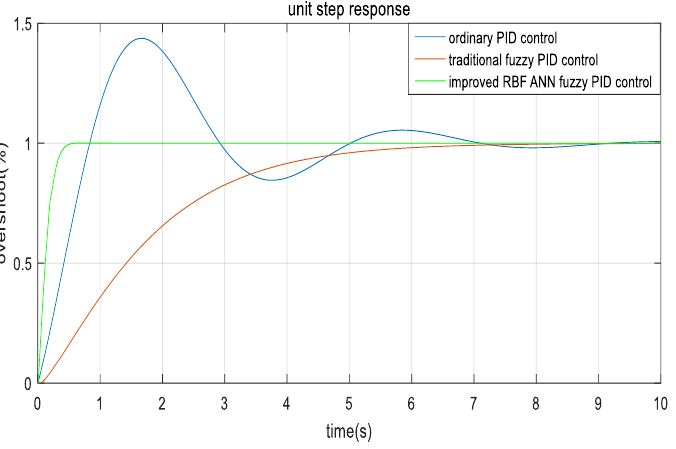
Figure 13. Unit step response comparison diagram.